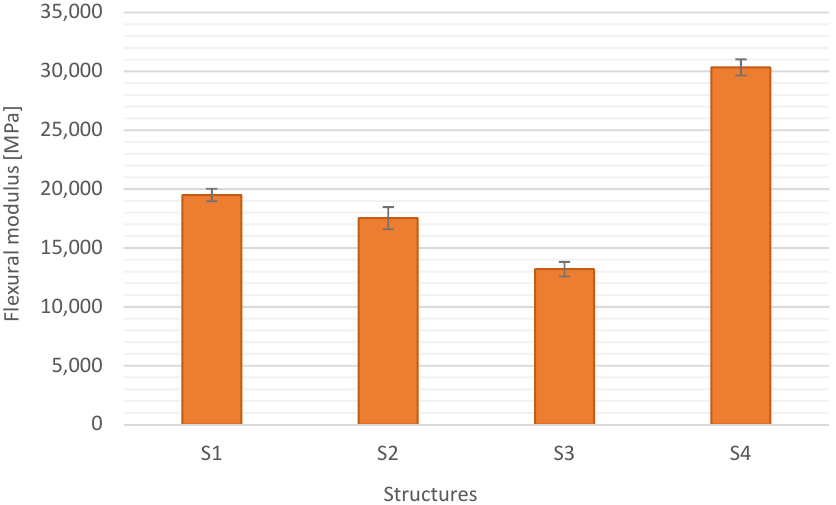
Figure 12. Flexural strength for different composite structures.